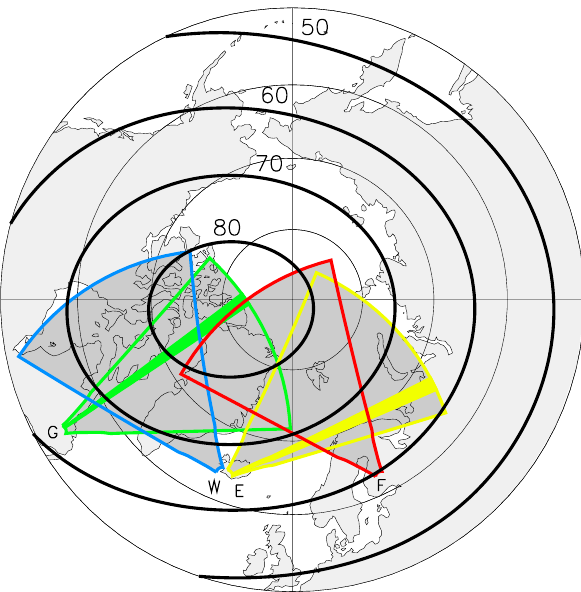
Fig. 2. Fields of view of four of the Northern Hemisphere Super- DARN radars (Goose Bay (G), Iceland West (W), Finland (F), and Iceland East (E)). The shaded beams represent Goose Bay beam 4 (Green) and Iceland East beam 13 (Yellow). The bold lines repre- sent lines of constant AACGM latitude (values as